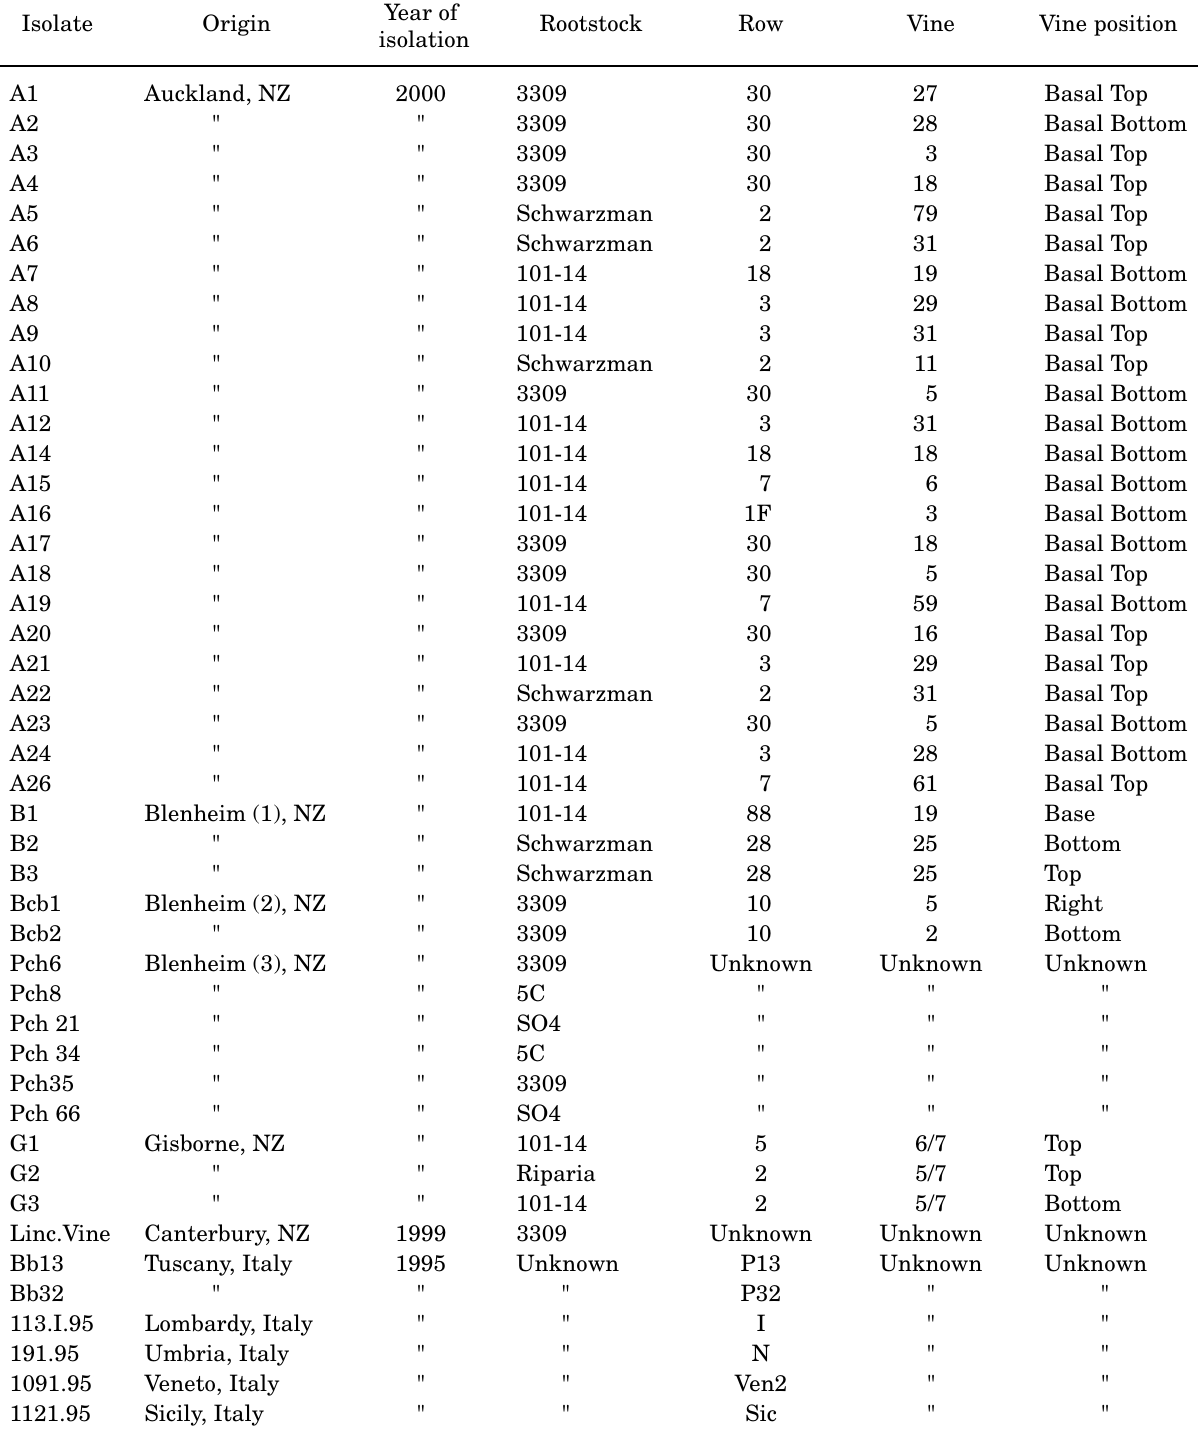
Table 1. Origin of Phaeomoniella chlamydospora isolates used in this study.